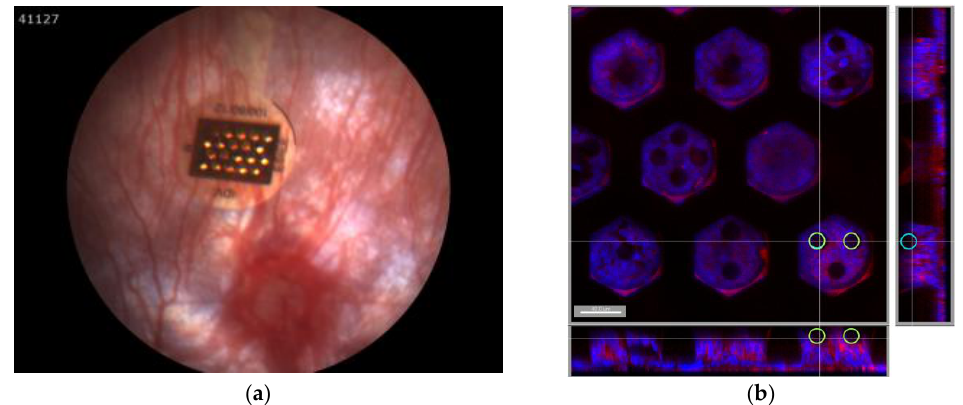
Figure 3. ( a ) Verification of the correct placing of the implant in sub-retinal position two weeks after implantation: Eye fundus of P23H rats with the implant obtained with a Micron III; ( b ) Confocal image of the retinal tissue and implant, where blue cells represent the bipolar cells after 19